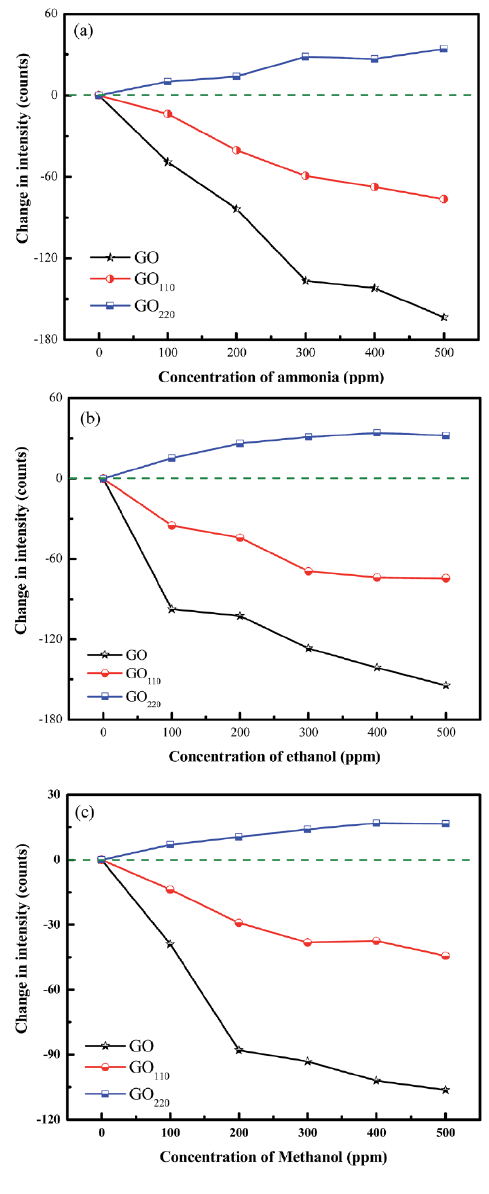
Figure 12. Change in output intensity at gas concentrations between 0 and 500 ppm of ( a ) ammonia ( b ) ethanol and ( c ) methanol for GO and rGO (GO 110 and GO 220 ). Reprinted from [132]. High to sensitive and selective VOCs detection has been also explored in [133] by Some and co- workers by means of the fabrication of GO, rGO and mixed GO/rGO thin-films onto the end tip of